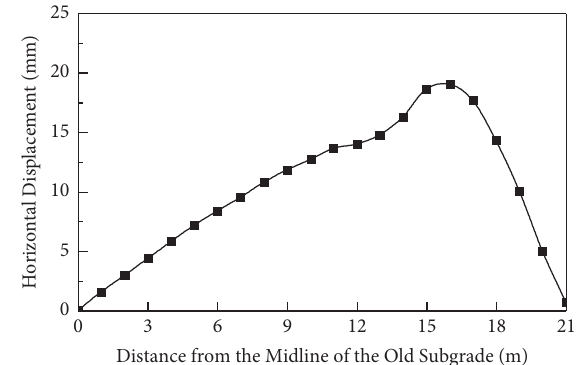
Figure 10: Horizontal displacement at foot of new subgrade